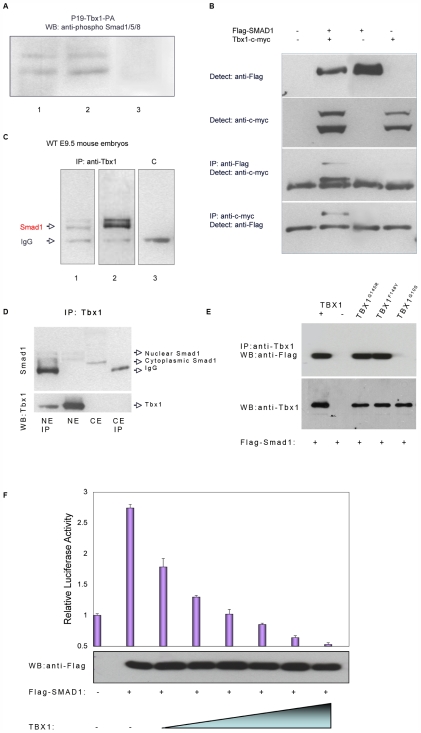
Tbx1 interacts with Smad1.a) Western blot analysis of affinity-purified nuclear extracts from P19-Tbx1-PA (lane 1) and P19-PA (lane 3) cells, compared non-purified nuclear extracts of P19-Tbx1-PA cells (lane 2), using an antibody anti-Phospho-SMAD1/5/8. b) Western blot analyses of reciprocal coimmunoprecipitation (IP) experiments using the antibodies indicated. NIH3T3 cells were co-transfected transiently with Tbx1-cmyc and Smad1-Flag expression vectors. c) Western blot analyses of nuclear extracts from wild type E9.5 mouse embryos immunoprecipitated with an anti-Tbx1 antibody (lanes 1 and 2) or with anti-rabbit IgG (lane 3) and revealed with an anti-SMAD1 antibody (lane 1 and 3) and an anti-Phospho-SMAD1/5/8 antibody (lane 2). d) Immunoblotting with anti-Smad1 antibody of nuclear extracts of wild type mouse embryos (E9.5) coimmunoprecipitated with anti-Tbx1 (NE-IP), total nuclear extracts (NE), total cytoplasmic extracts (CE), and cytoplasmic extracts coimminoprecipitated with anti-Tbx1 (CE-IP). e) Coimmunoprecipitation of WT TBX1, TBX1G145R, TBX1F148Y, TBX1G310S and Flag-SMAD1 transiently transfected in NIH 3T3 cells. The TBX1G145R and TBX1F148Y mutants physically interact with Smad1, while TBX1G310S is unable to bind Smad1 indicating that Glycine 310 is important for this interaction. f) Luciferase assay using Cos7 cells transfected with the SMAD-responsive reporter NTK-tetramer-luc. Transfected SMAD1 activates the reporter while increasing amounts (5 to 100 ng) of co-transfected TBX1 suppresses it.